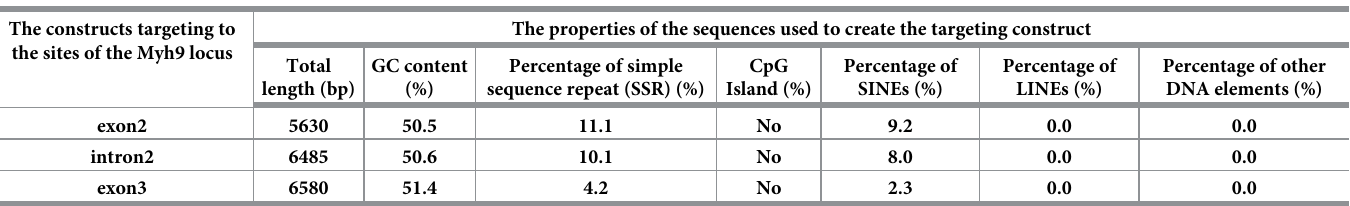
Table 4. The bioinformatic analysis of the sequences used to create the constructs targeting to different sites of the Myh9 locus. The constructs targeting to The properties of the sequences used to create the targeting the sites of the Myh9 locus